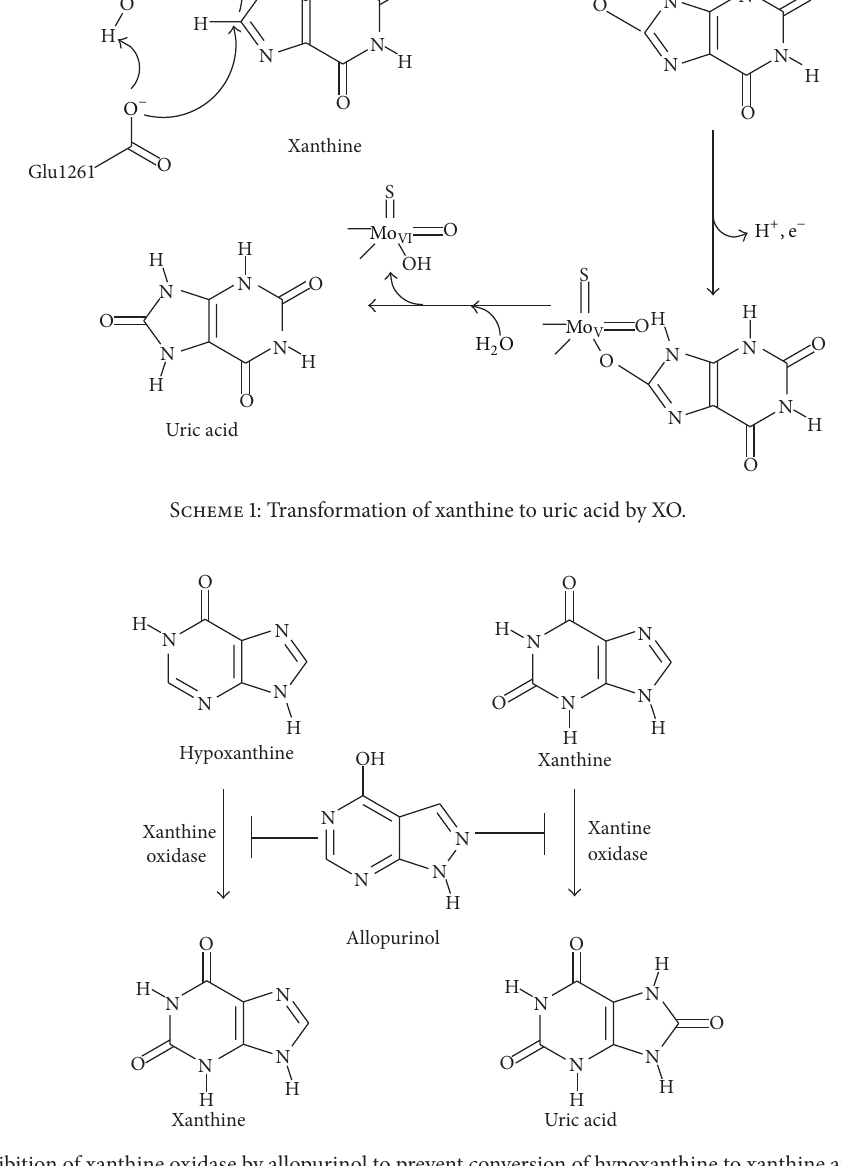
Figure 1: Inhibition of xanthine oxidase by allopurinol to prevent conversion of hypoxanthine to xanthine and/or uric